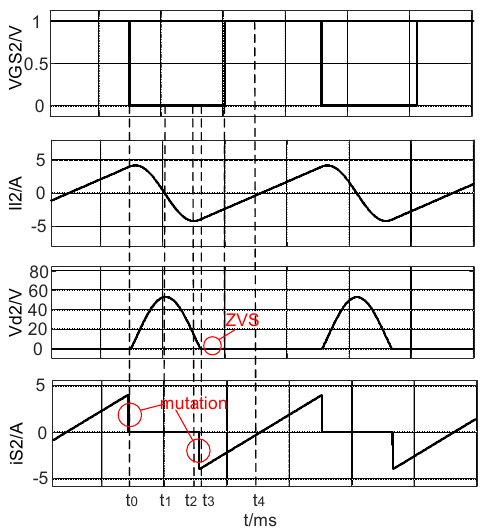
Figure 5. Traditional transmitter modal waveforms. Table 1. Modal analysis of the transmitter .